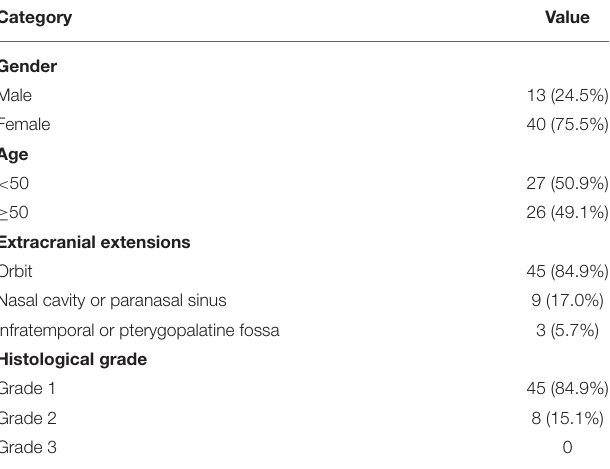
TABLE 1 | Characteristics of study population.